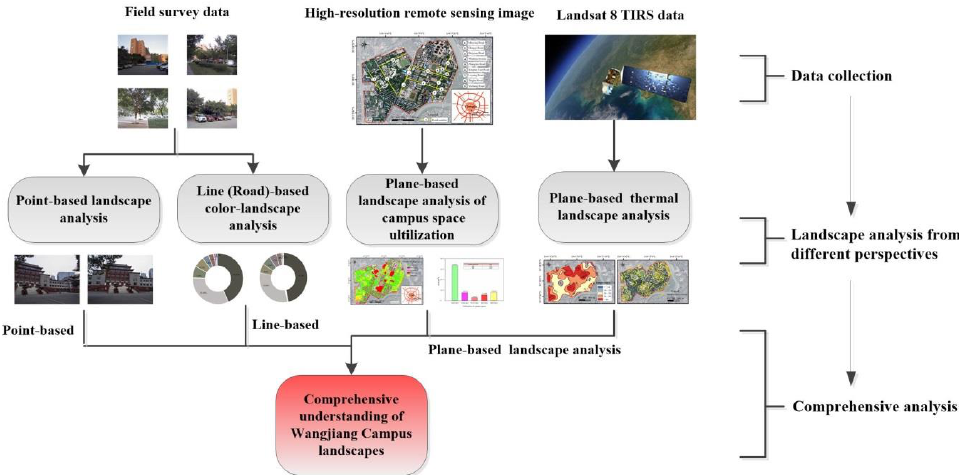
Figure 5. Technical route of this study.